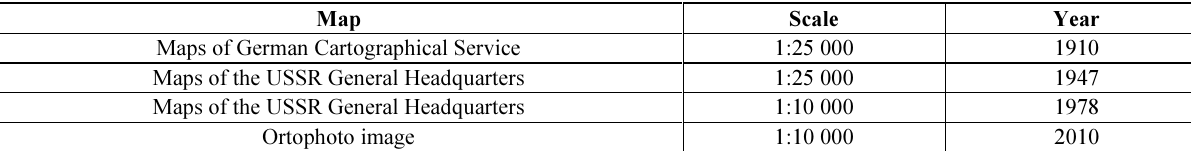
Table 1. Cartographic material used for the assessment of coastline dynamics Map Scale Maps of German Cartographical